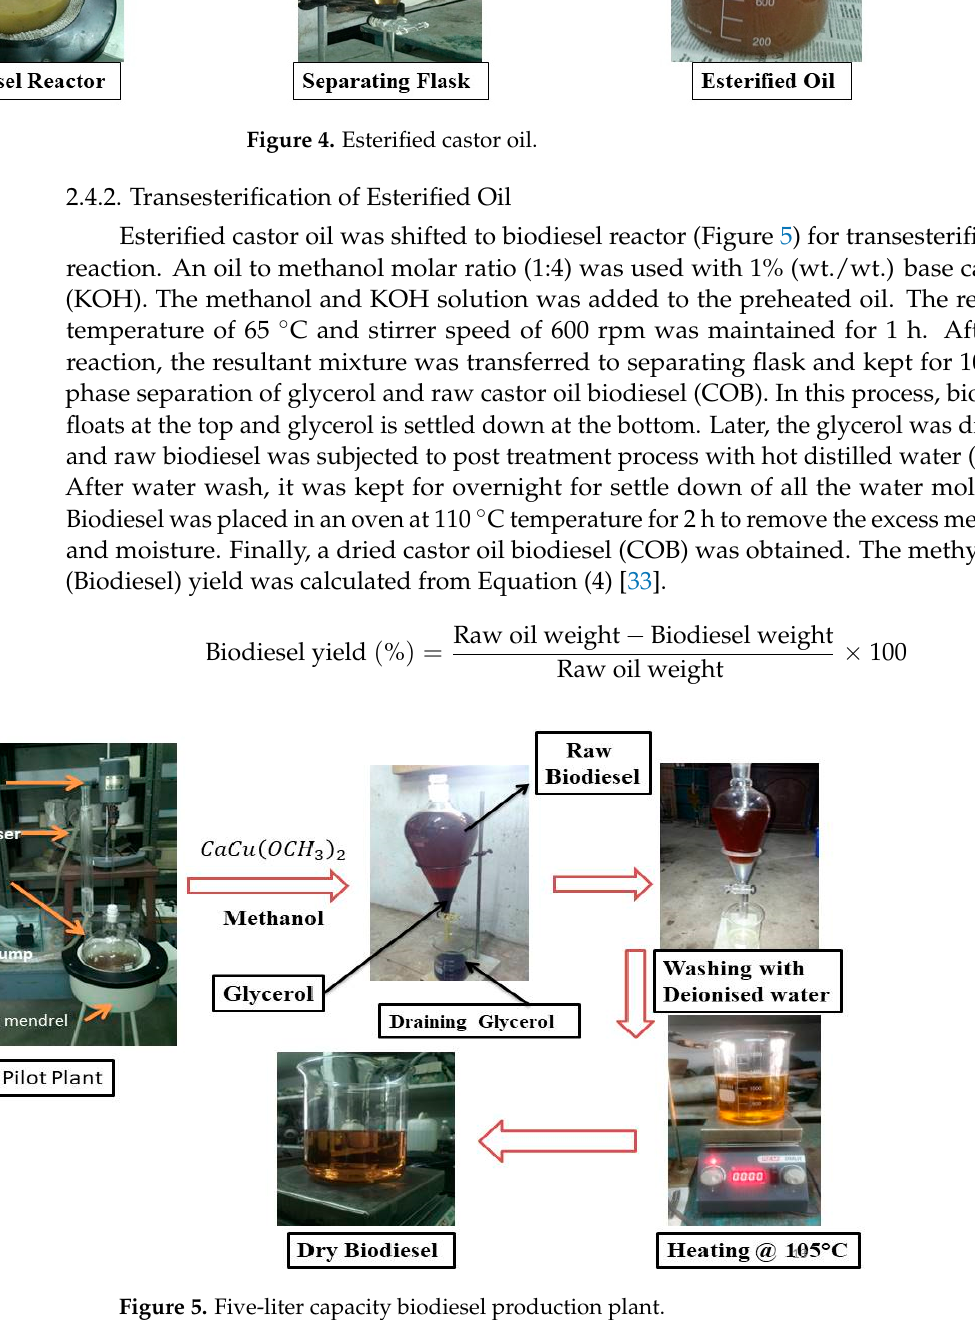
Figure 5. Five-liter capacity biodiesel production plant.